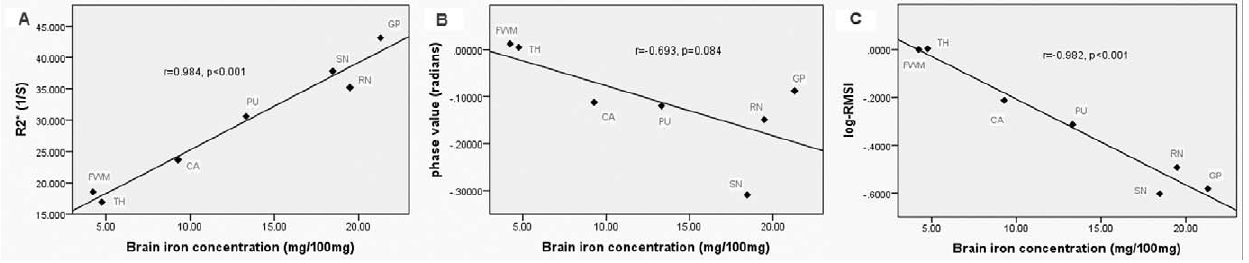
Figure 3. The Scatter plots between three methods and brain iron concentration as published. (A), The correlation between R2* and brain iron concentrations. (B), The correlation between phase values and brain iron concentrations. (C), The correlation between log( 2 RMSI) and brain iron concentration. CA=caudate; PU=putamen; GP=globus pallidus; TH=thalamus; RN=red nucleus; SN=substantia nigra; FWM=frontal white